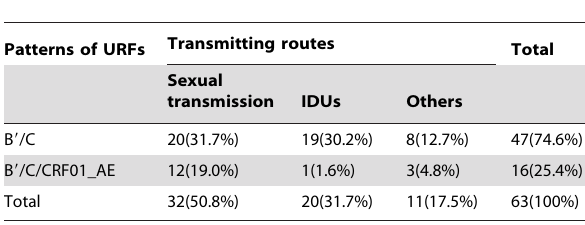
Table 2. Distribution of URFs of different patterns in transmitting